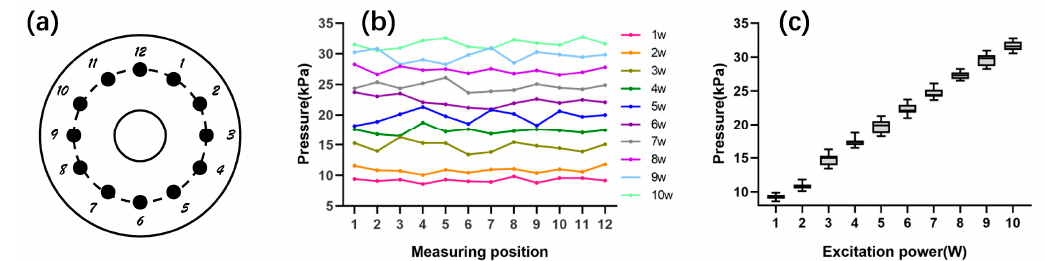
Figure 4. Transducer surface acoustic pressure; ( a ) schematic diagram of sampling points; ( b ) acoustic pressure at each point under different excitation conditions; ( c ) the variation trend of surface acoustic pressure.